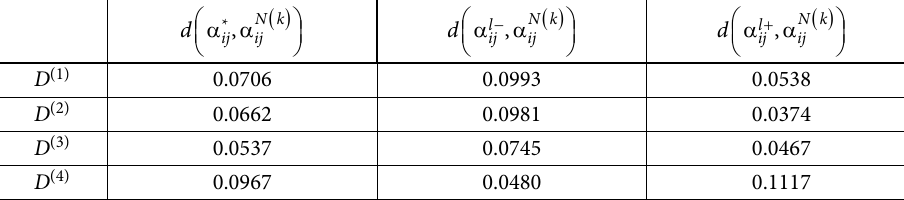
Table 6. Distances between PIS / NIS l / NIS r and D N ( k )